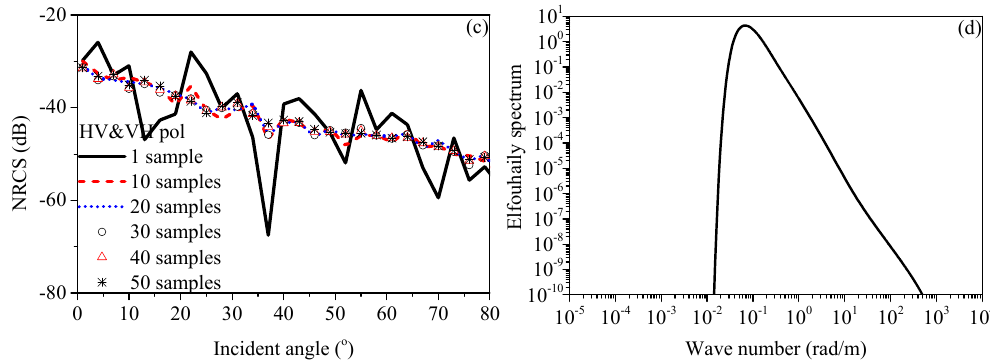
Figure 4. The NRCS results calculated by full-polarized facet based scattering model (FPFSM) with different samples for u 10 = 5 m/s and the Elfouhaily spectrum as a function of the wavenumber. ( a ) NRCS results at HH polarization mode; ( b ) NRCS results at VV polarization mode; ( c ) NRCS results at HV and horizontal-transmit-vertical-receive (VH) polarization modes; ( d ) Elfouhaily spectrum.